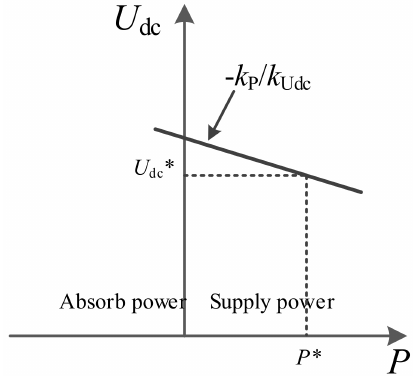
Figure 2. Droop-control characteristic of the DC voltage-active